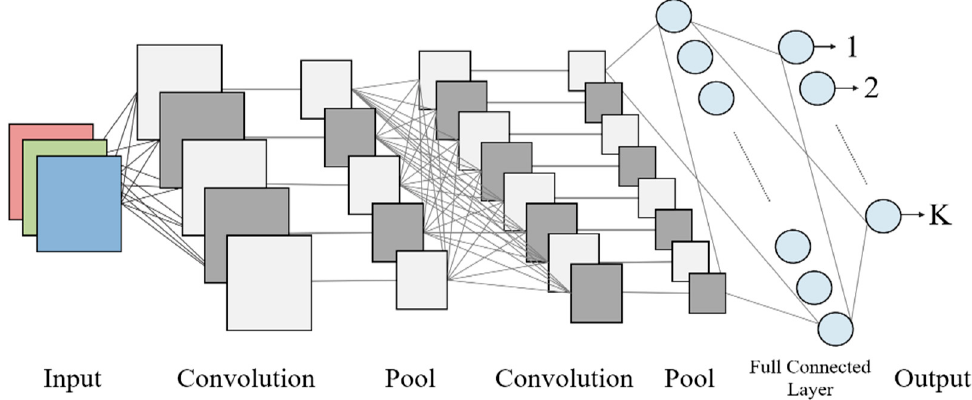
Figure 3. Convolutional neural network